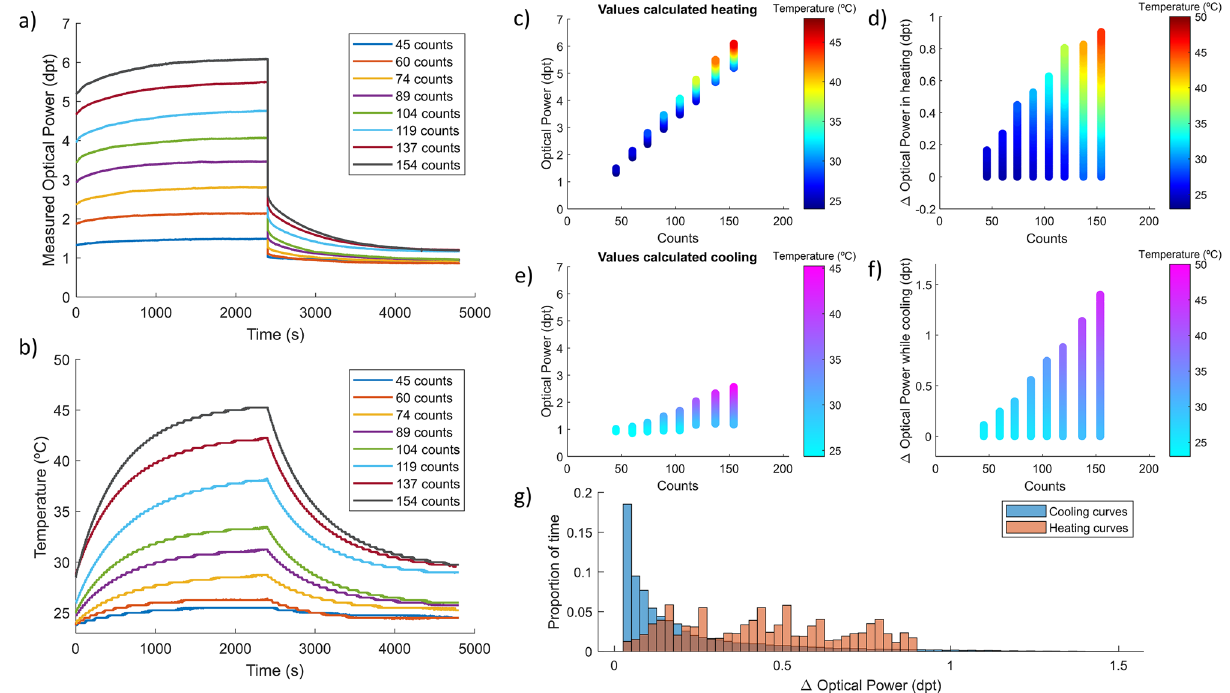
Figure 1. Characterization of temperature effect in a TL during long static states of different optical power. ( a ) Graphical description of the static experiment showing the optical power variation with time due to temperature variation. ( b ) Profile of the lens’ internal temperature during the experiment with different voltage driving signals. Measured optical power of the lens while heating ( c ) for different driving signals and cooling ( e ) at rest state. Estimated deviation, calculated from the difference between the initial point and measured optical power in the heating ( d ) and cooling ( f ) processes. ( g ) Histogram of optical power deviation while heating (red) and cooling (blue) to quantify the proportion of time the lens diverges a certain